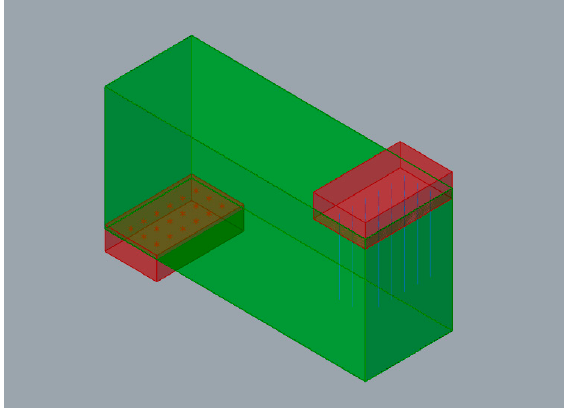
Figure 6. Case study loading conditions.